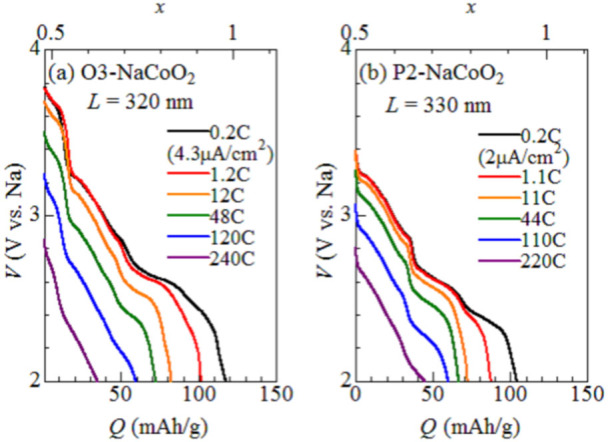
Discharge curves of films of (a) O3-NaCoO2 and (b) P2-NaCoO2.Film thicknesses (L) are 320 nm and 330 nm, respectively.